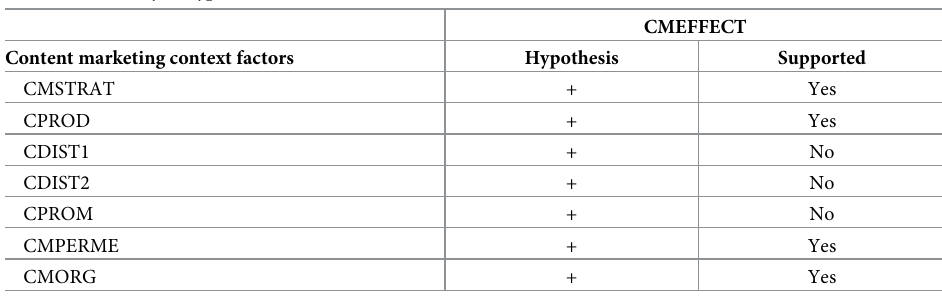
Table 3. Summary of hypothesized